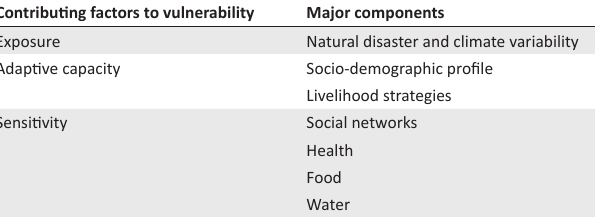
TABLE 3: Categories of major components contributing factors by the definition of vulnerability according to Intergovernmental Panel on Climate Change for the calculation of the Livelihood Vulnerability Index-Intergovernmental Panel on Climate